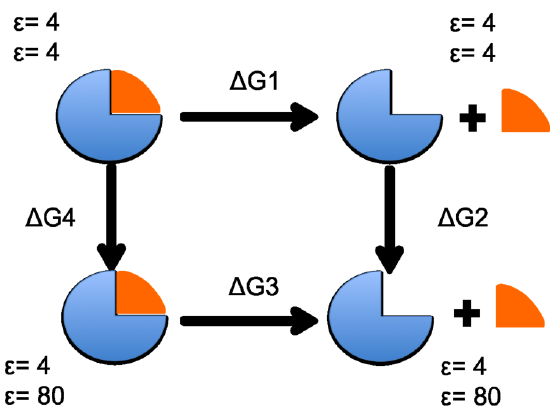
Figure 9. The thermodynamic cycle depicts the steps involved in the calculation of binding free energy of a protein subunit (orange) in the environment of a protein complex